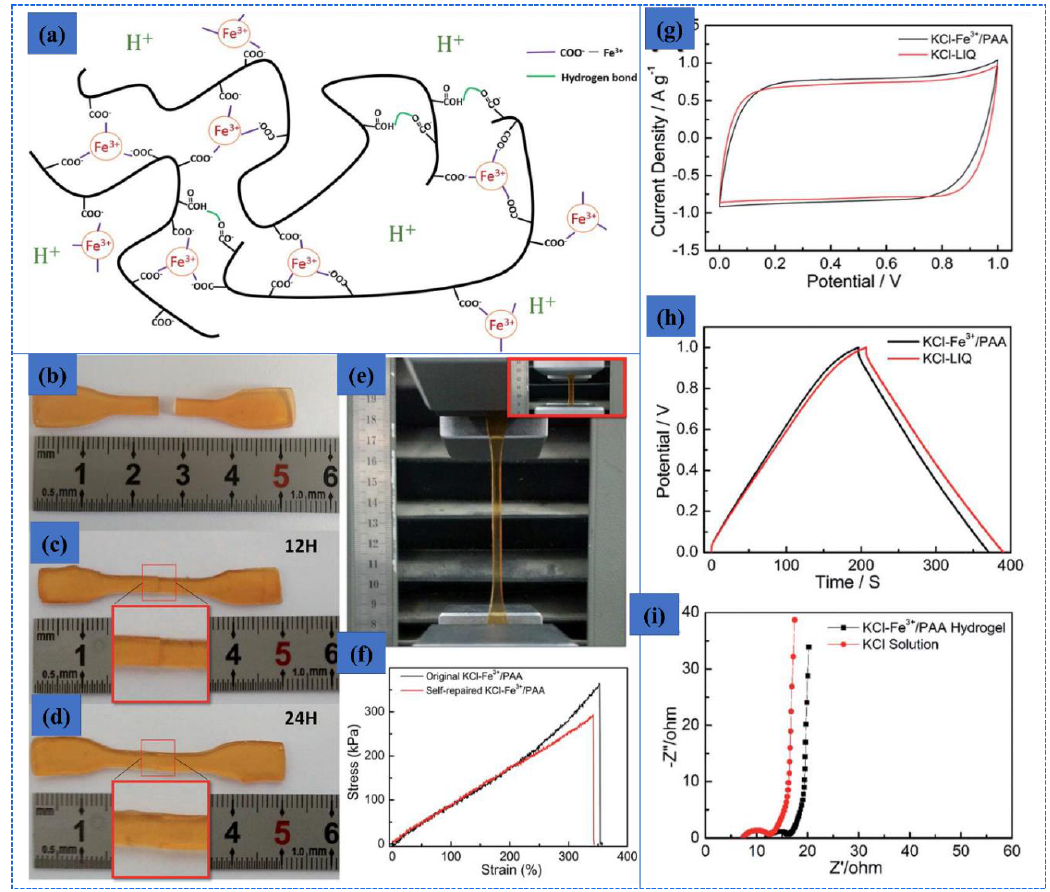
Figure 22. ( a ) Schematic illustration of the internal crosslinking effect of the KCl–Fe 3+ /PAA hydrogel. ( b – d ) Self-healing of a dumbbell-shaped hydrogel at room temperature: ( b ) the hydrogel after being cut, ( c ) the hydrogel after healing for 12 h, and ( d ) the hydrogel after healing for 24 h. ( e ) Stretching the self-healed hydrogel up to 200%. ( f ) Comparison of stress–strain curves between the original and self-repaired KCl–Fe 3+ /PAA hydrogel. ( g ) CV curves of the KCl–Fe 3+ /PAA F-supercapacitor and KCl L-supercapacitor at a scan rate of 5 mV s −1 . ( h ) Comparison of the charge/discharge profile between the KCl–Fe 3+ /PAA F-supercapacitor and KCl L-supercapacitor at a current density of 0.5 A g −1 . ( i ) Comparison of the Nyquist impedance plot of the KCl–Fe 3+ /PAA F-supercapacitor and KCl L-supercapacitor [196] .